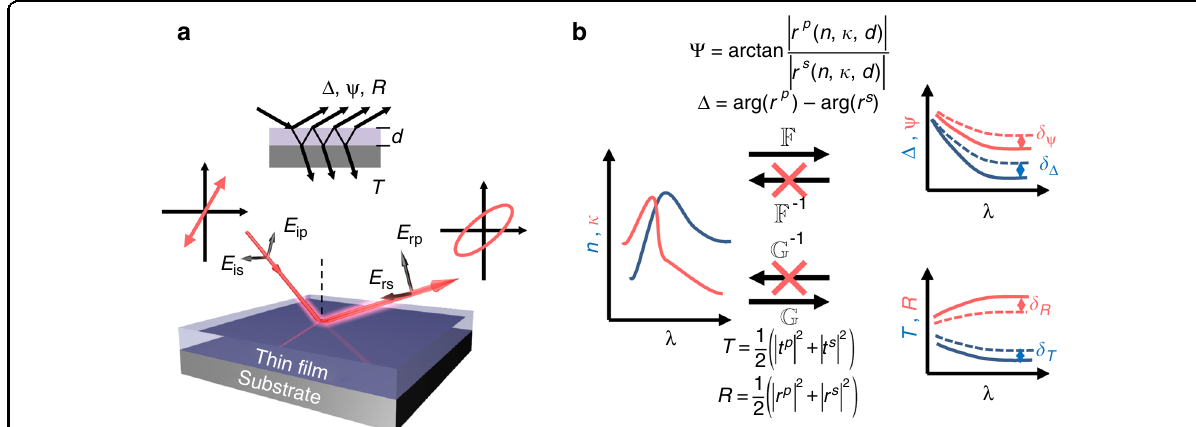
Fig. 1 Principle of R , T assisted ellipsometry. a In ellipsometry, light E i is obliquely incident onto a thin fi lm with unknown ( n , κ , d ), which is on a substrate with known optical constants. Multiple beam interference occurs in the fi lm, as shown in the inset. The orthogonal polarization components ( E p and E s ) have unequal re fl ection coef fi cients r p and r s , leading to elliptically polarized re fl ection E r . p and s refer to polarizations with electric fi elds parallel and normal to the plane of incidence, respectively. b The ellipsometric angles Ψ and Δ are de fi ned by, tan Ψ e i Δ = r p / r s , as denoted by F . The total transmittance T and re fl ectance R are calculated by averaging the contributions from the p - and s -polarizations, denoted by G . The physical process from ( n , κ , d ) to ( Ψ , Δ , R , T ) has been well studied and can be modeled accurately as functions F and G . On the other hand, the inverse, i.e., analytically inferring ( n , κ , d ) from ( Ψ , Δ , R , T ), is generally impossible, and iterative fi tting techniques have therefore been developed to numerically search a set of ( n , κ , d ) that best fi ts the experimental data. Solid lines denote experimentally measured ( Ψ , Δ , R, T ), dashed lines present results recovered by the tentative ( n, κ , d )